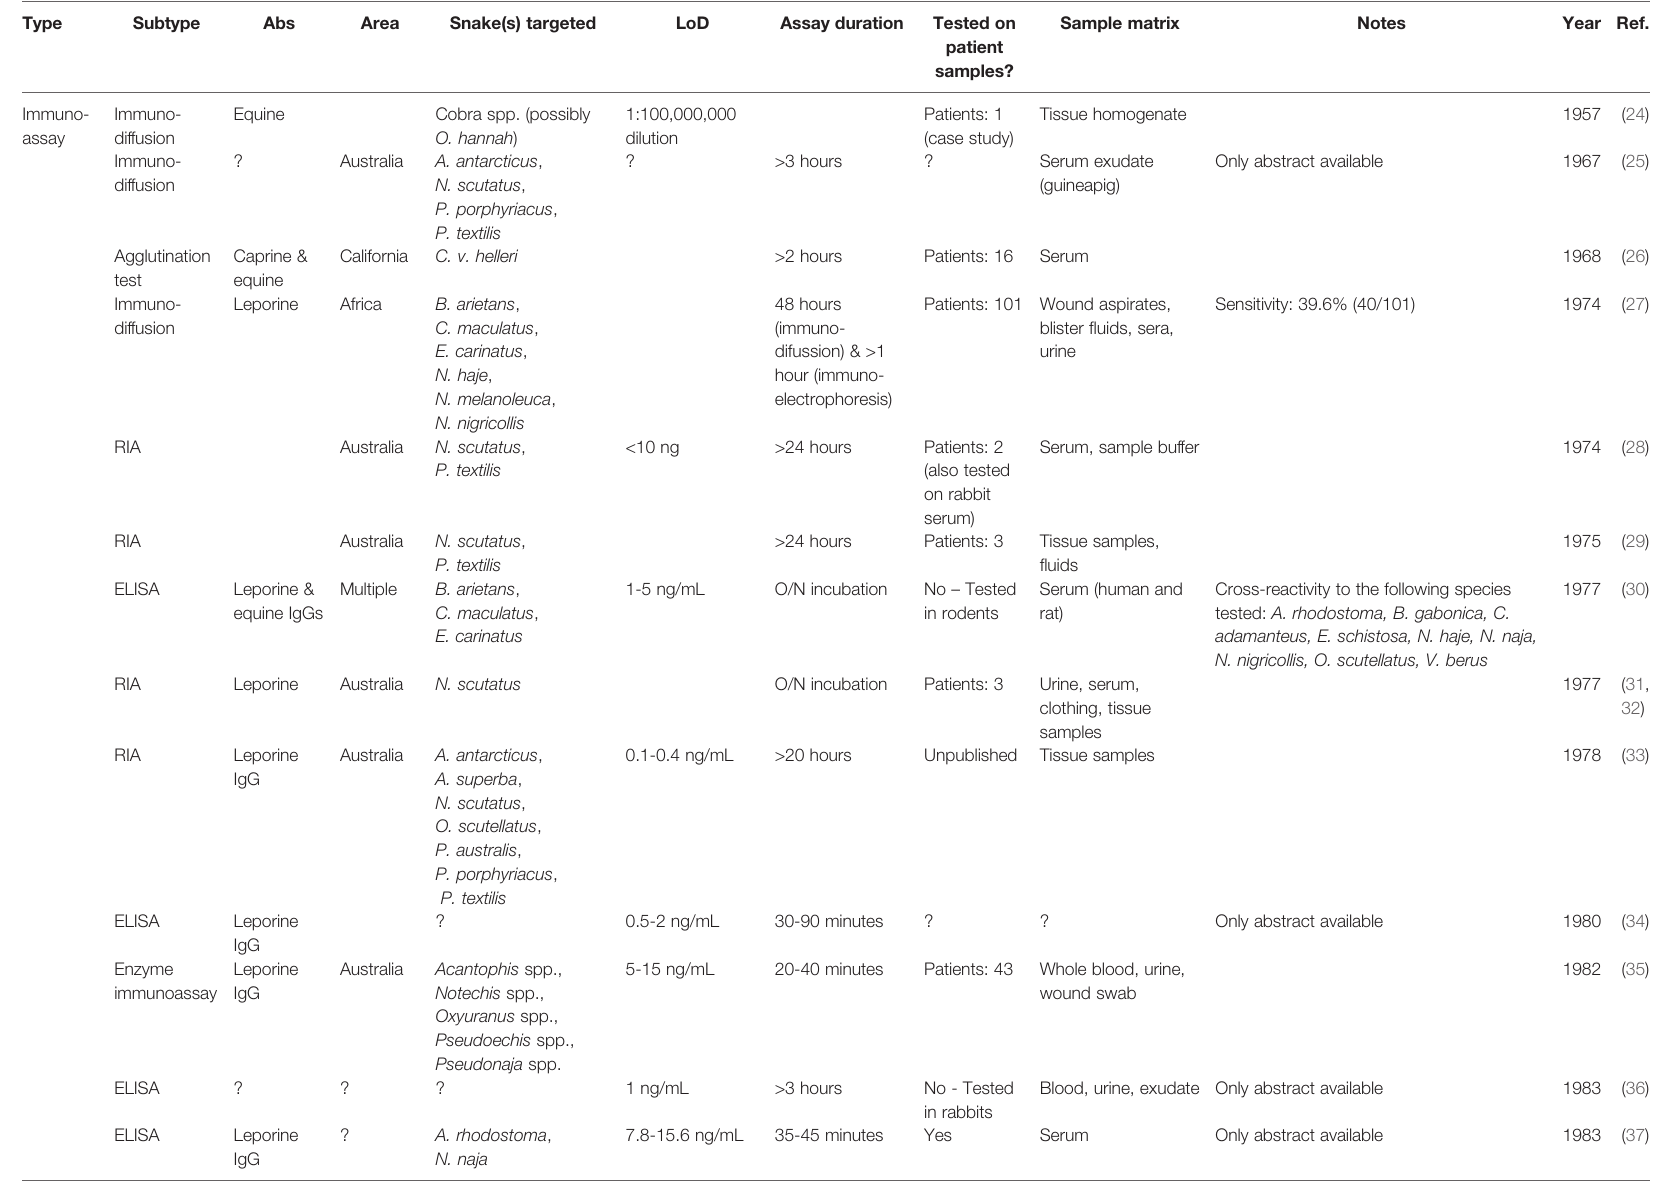
TABLE 1 | Overview of snakebite diagnostics capable of differentiating snake